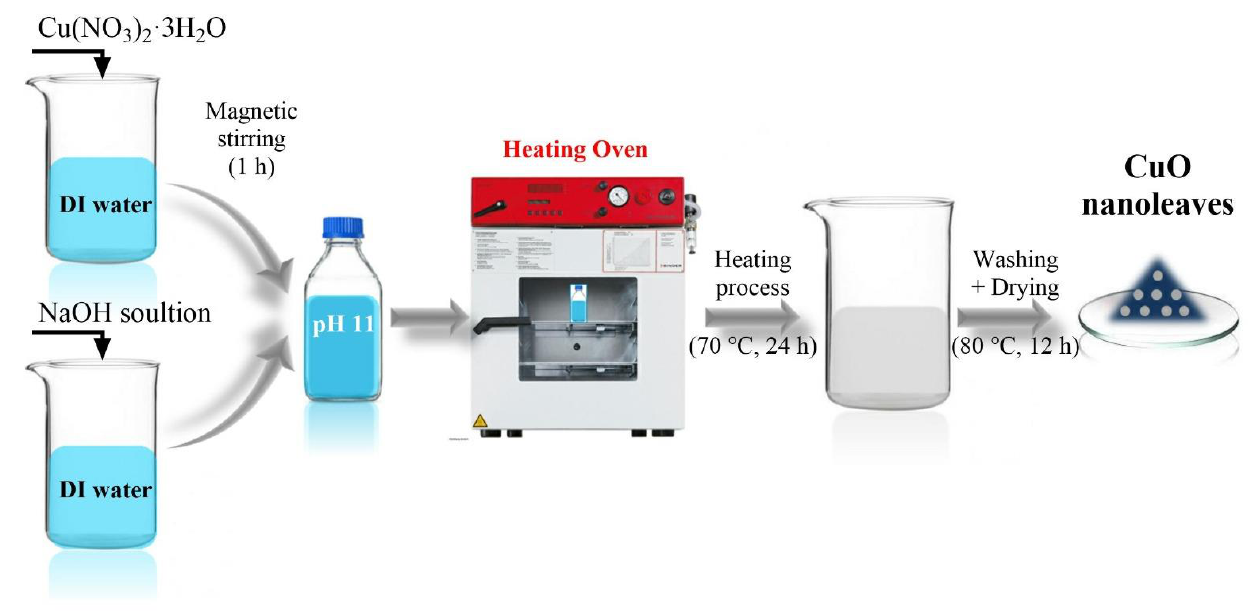
Figure 1. Schematic to synthesize leaf-shaped CuO nanosheets.